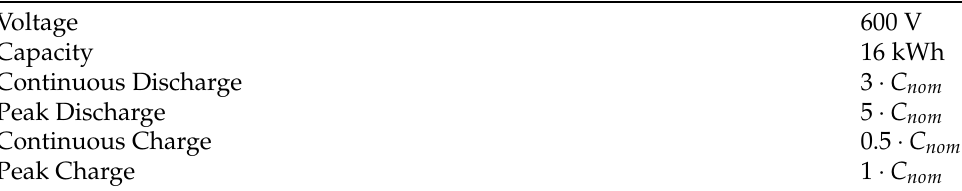
Table 3. Main properties of the battery